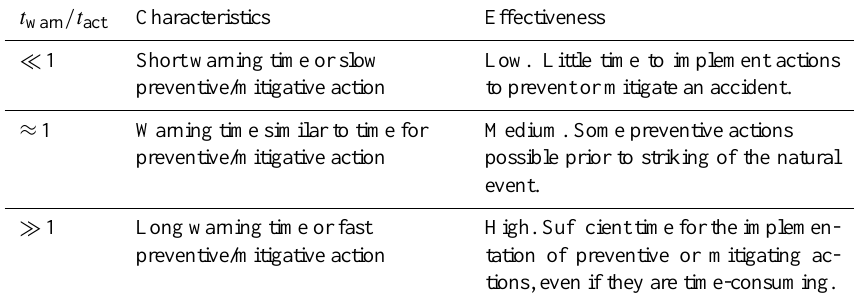
Table 6. Characteristics and effectiveness of a Natech-specific early-warning system as function of t warn /t act .